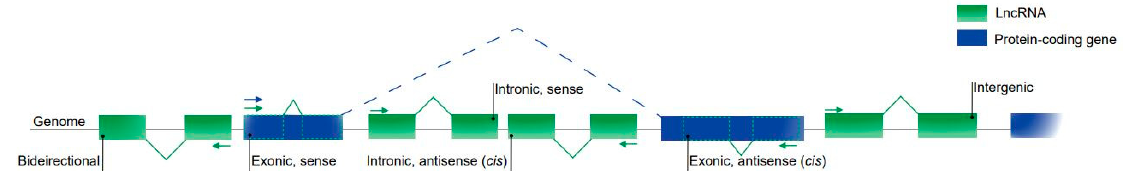
Figure 1. Classification of lncRNAs based on their genomic location. Intergenic lncRNAs are located between two protein- coding genes. Exonic and intronic lncRNAs are located entirely in the exonic and intronic regions of a protein-coding gene, respectively. Sense lncRNAs are transcribed from the same strand and in the same direction as the protein-coding genes; they can be both exonic and intronic. Antisense lncRNAs are transcribed from the opposite strand of the protein-coding genes and can also be both exonic and intronic. Bidirectional lncRNAs are located within the promoter region of a protein-coding gene.